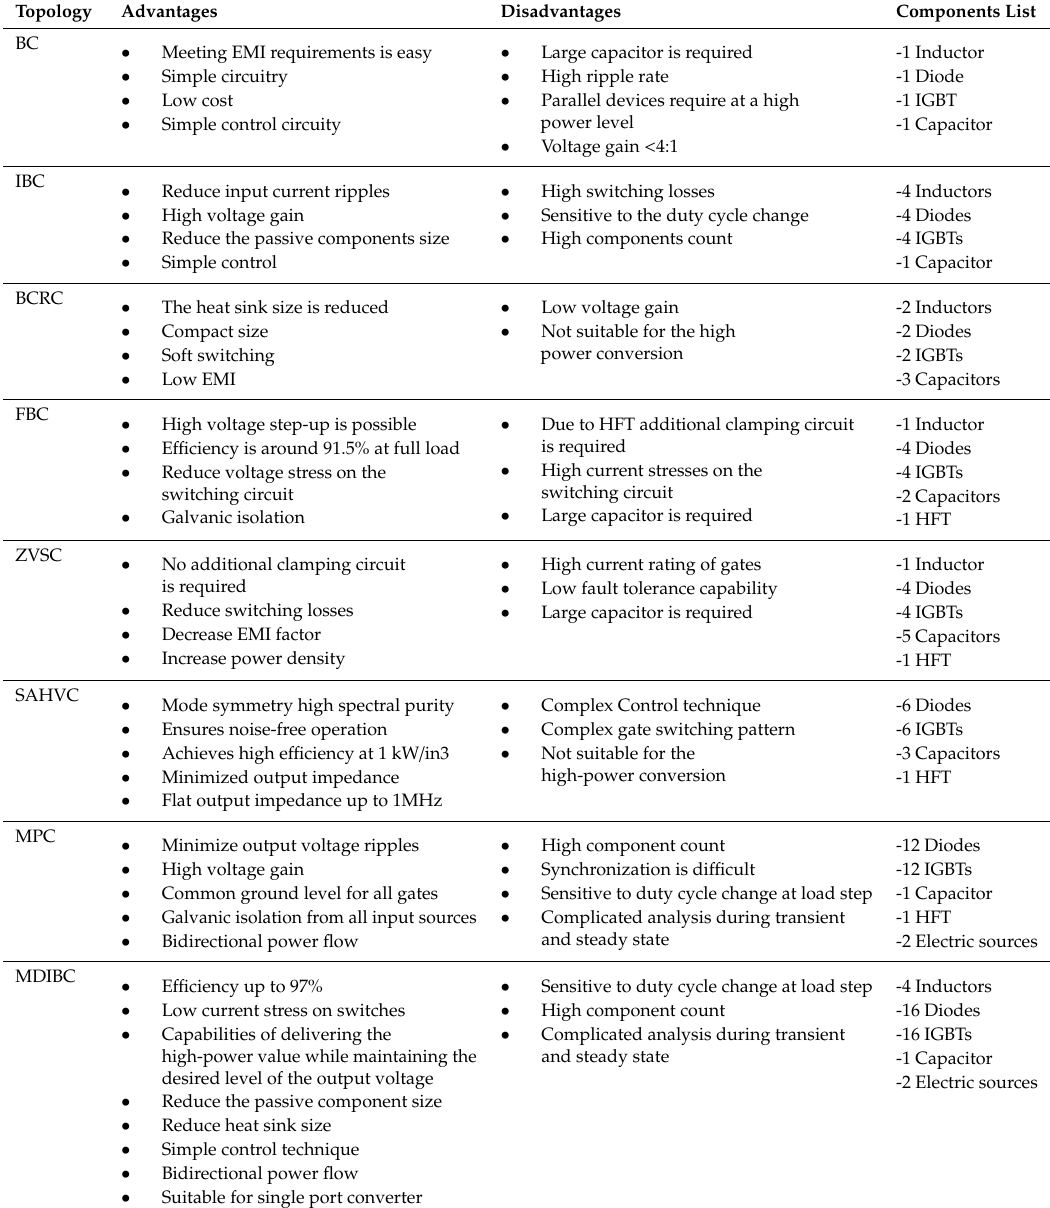
Table 8. Summary of DC-DC converter topology for BEV and PHEV